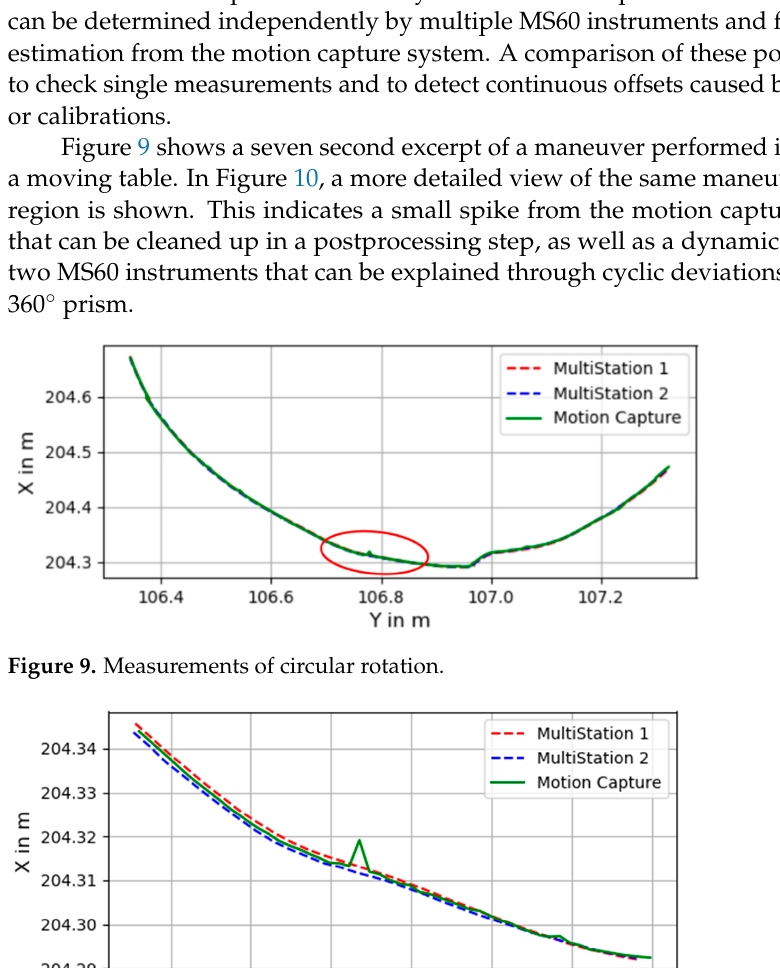
Table 3. Coordinate differences dependent on the velocity.